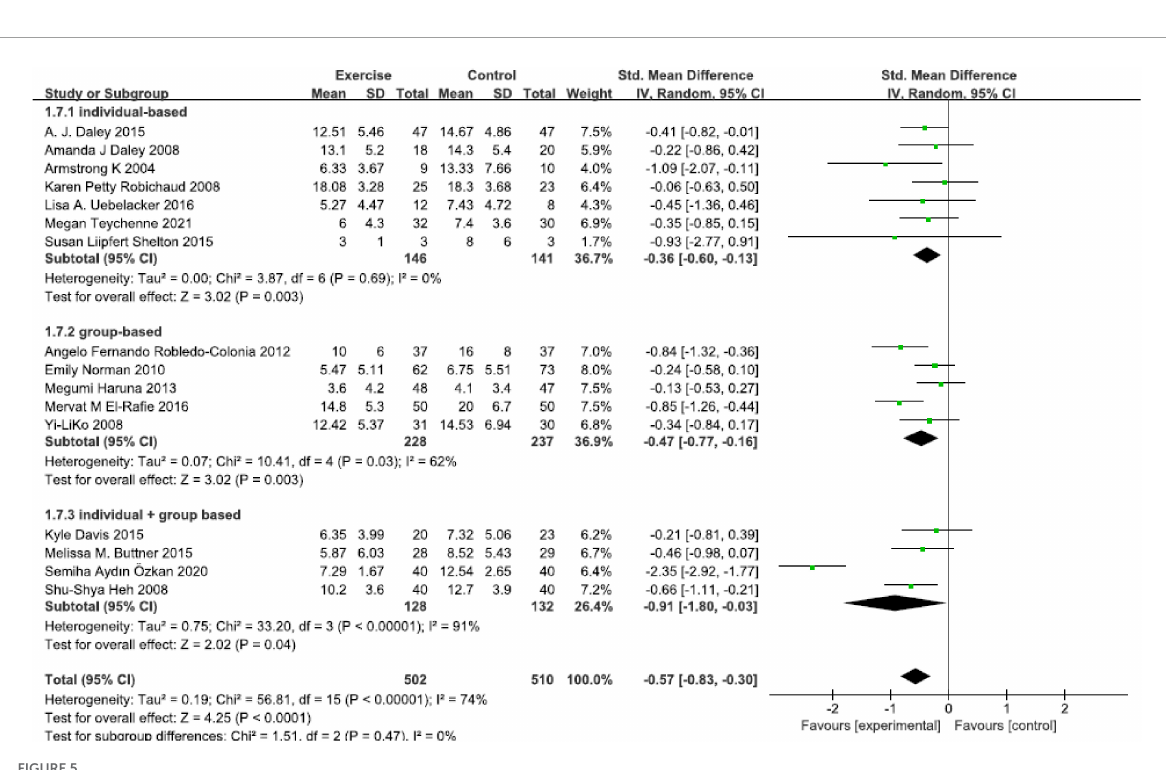
FIGURE5 Forest plot of the perinatal depression symptoms scores at different physical exercise